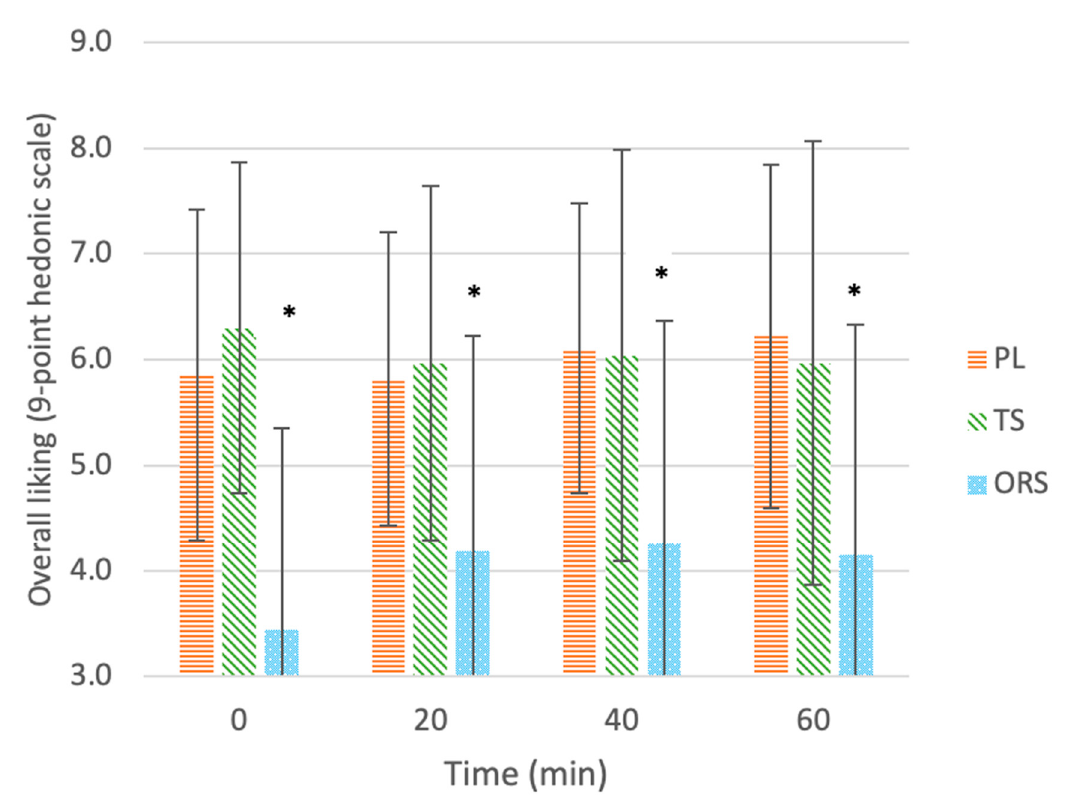
Figure 5. Overall liking of drinks: ORS—oral rehydration solution, PL—placebo, TS—traditional sports drink, on a 9-point hedonic scale throughout 60 min of exercise. Values are mean ± SD. * Significant effect of the treatment vs. the placebo ( p < 0.05).